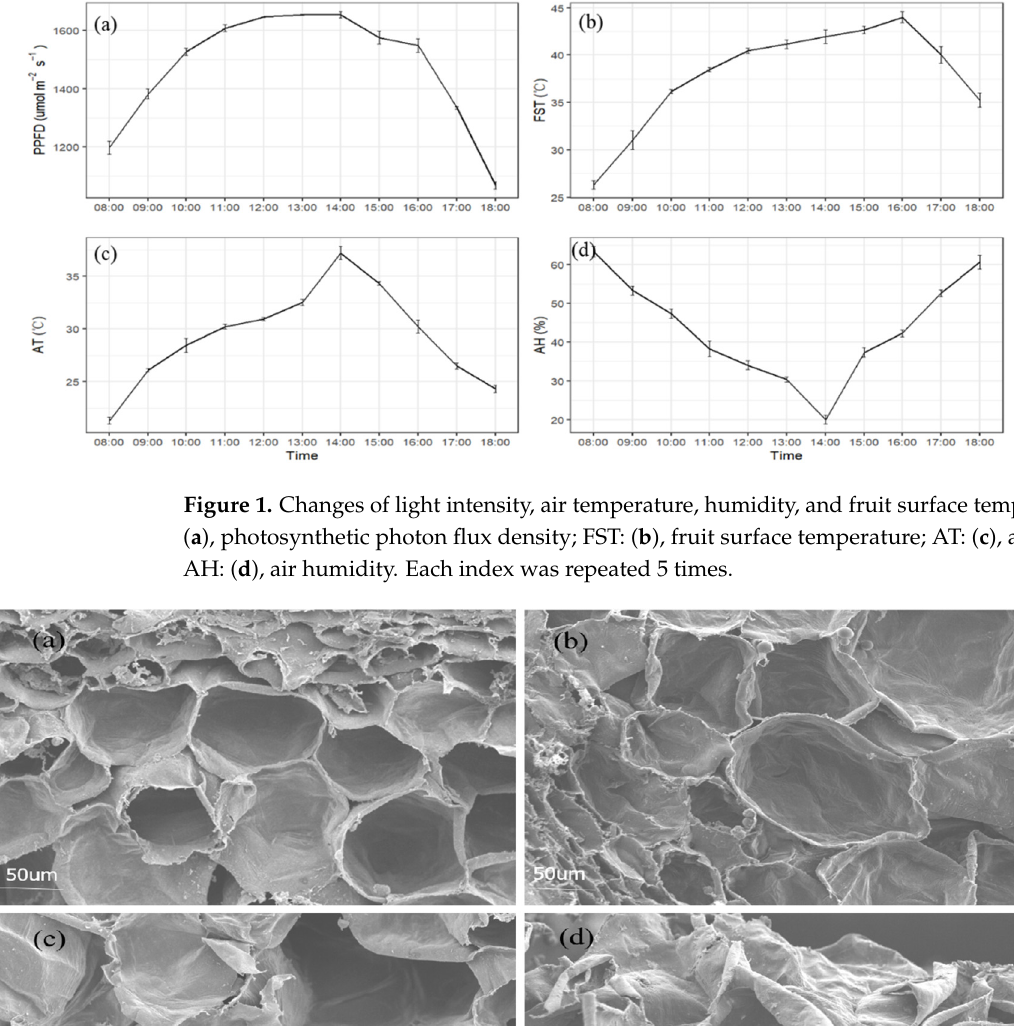
Figure 1. Changes of light intensity, air temperature, humidity, and fruit surface temperature. PPFD: ( a ), photosynthetic photon flux density; FST: ( b ), fruit surface temperature; AT: ( c ), air temperature; AH: ( d ), air humidity. Each index was repeated 5 times.